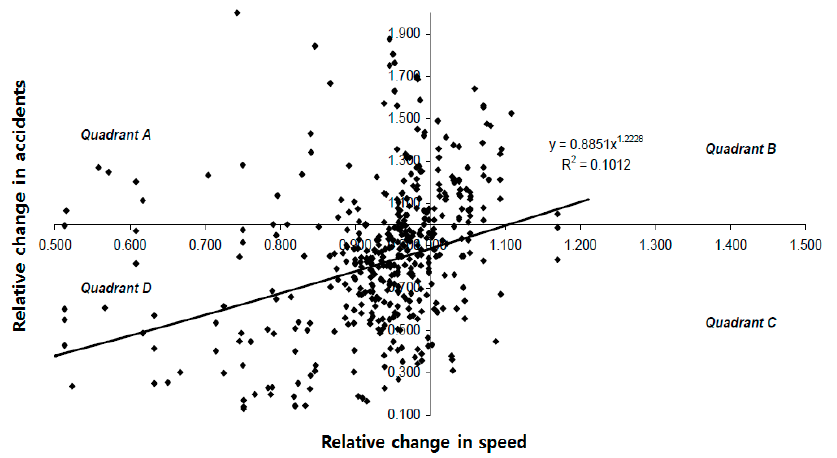
Figure 20. Simple linear relationship between the relative change in speed and the corresponding change in accident frequency.